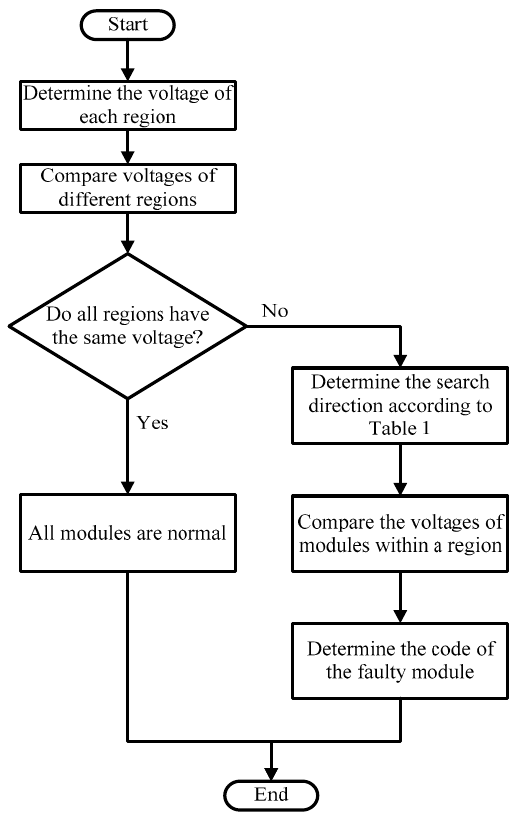
Figure 3. Regional division of 4 × 3 series-parallel PV module array.